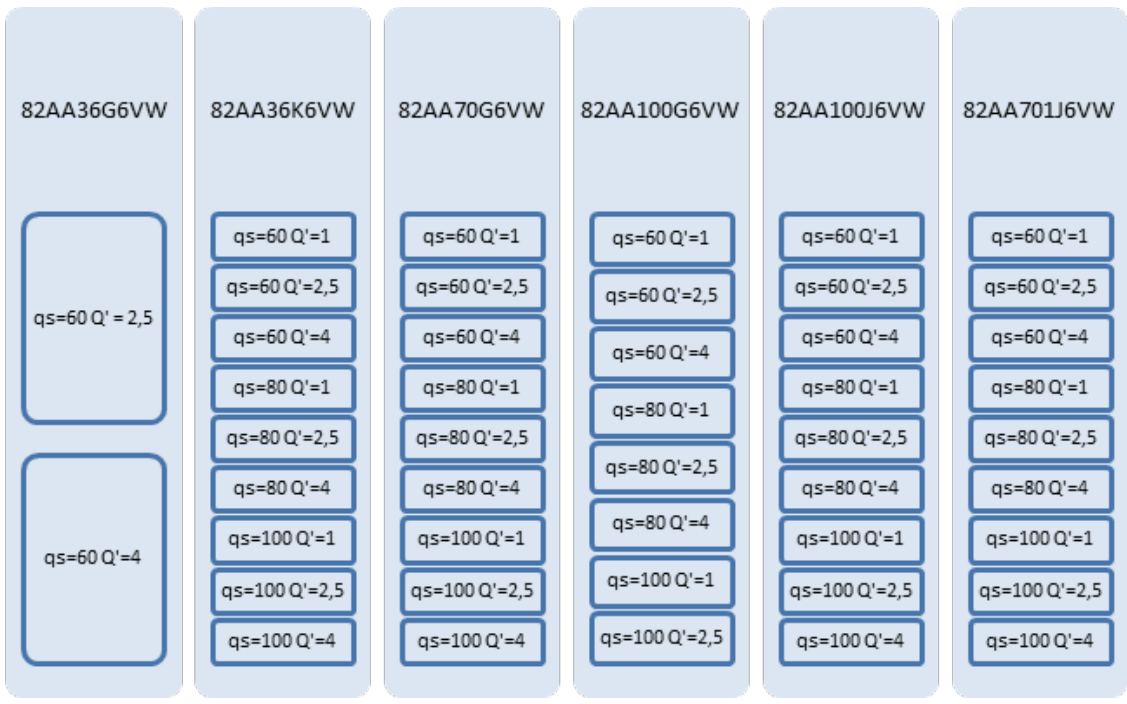
Figure 2. Grinding wheels and grinding conditions of the experimental database for training and testing the ANN-based sensors.